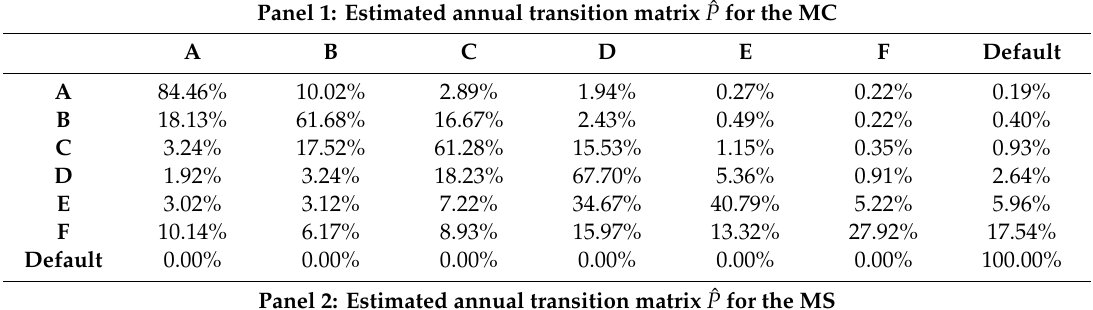
Table 4. Estimated annual transition matrices. Panel 1: Estimated annual transition matrix ˆ P for the MC